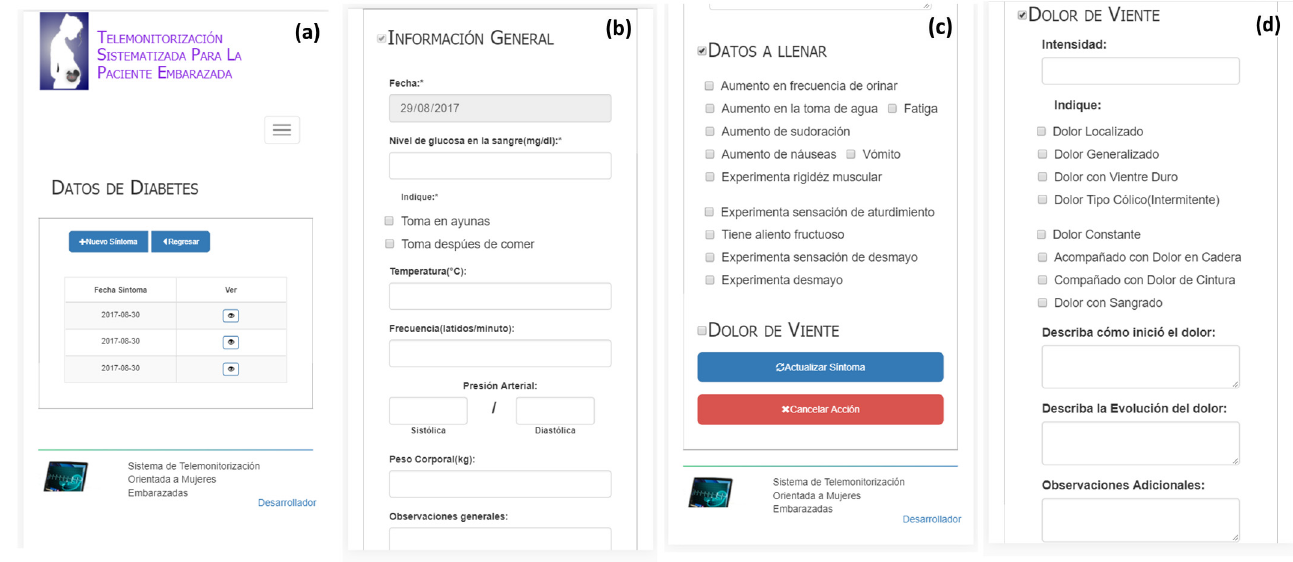
Figure 4. Diabetes symptom data (from left to right): ( a ) list, ( b ) general information, ( c ) data to fill out, and ( d ) belly pain data.